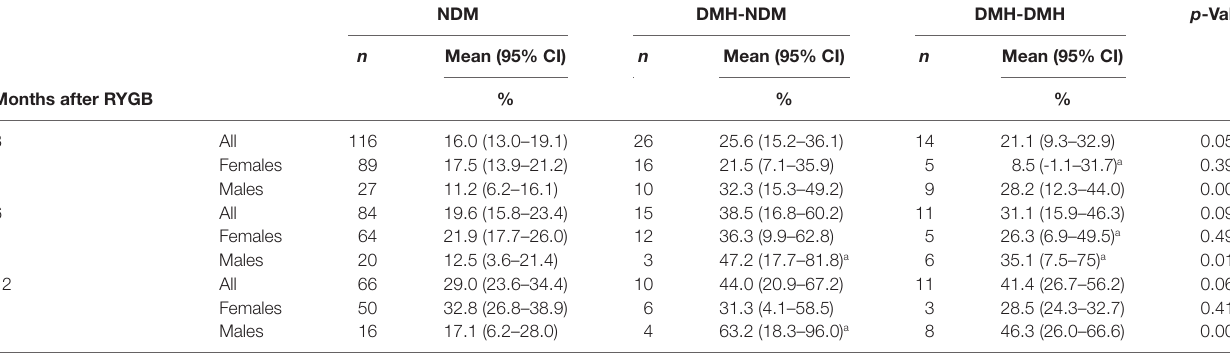
Data are shown in percent (%) as mean with a 95% CI, except in a , were CI where larger than minimum and maximum values, which are reported instead. NDM, patients without diabetes mellitus (DM); DMH-NDM, patients with DM in remission after RYGB; DMH-DMH, patients with DM not in remission after RYGB; n, number of patients; RYGB, Roux-en-Y gastric